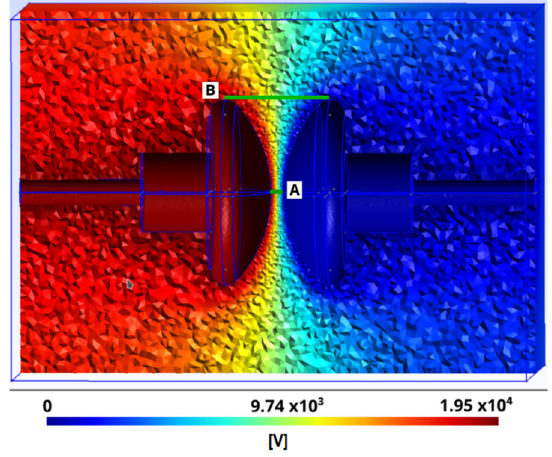
Figure 7. Electrical scalar potential φ obtained in CM when solving system of equations shown in Equation (16), meshed with 2,790,589 tetrahedra and cuts A and B for comparison.